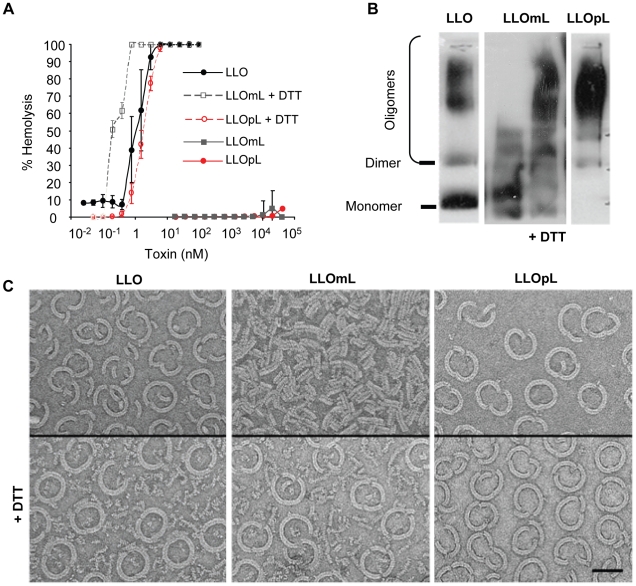
Characterization of the LLO variants.(A) Hemolytic activity of LLO, LLOmL, and LLOpL was measured at pH 7.4, 37°C. DTT  =  dithiothreitol. (B) LLO, LLOmL, and LLOpL were incubated with erythrocyte ghost membranes, in the presence or absence of DTT, washed and suspended in 1% detergent. The samples were subjected to gradient electrophoresis, in the presence of 1% detergent, and LLO was detected by western blotting using anti-LLO antibodies. (C) Toxins were incubated for 1 h on cholesterol/DOPC lipid layers in the presence or absence of DTT. The samples were processed and analyzed by transmission electron transmission microscopy. Scale bar = 50 nm.